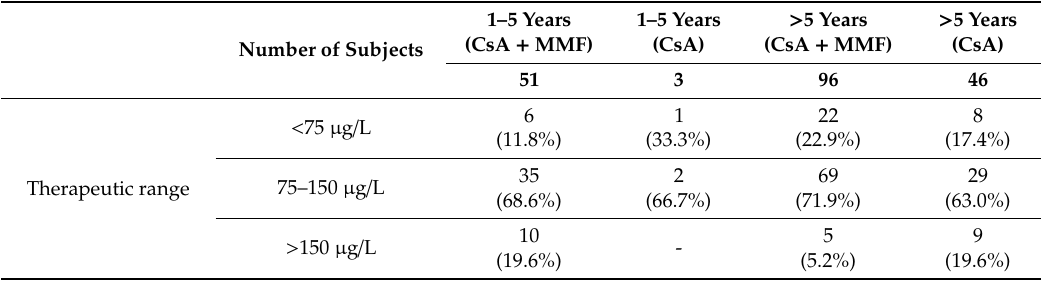
Table 9. Comparative table of CsA C 0 compliances within the therapeutic range.